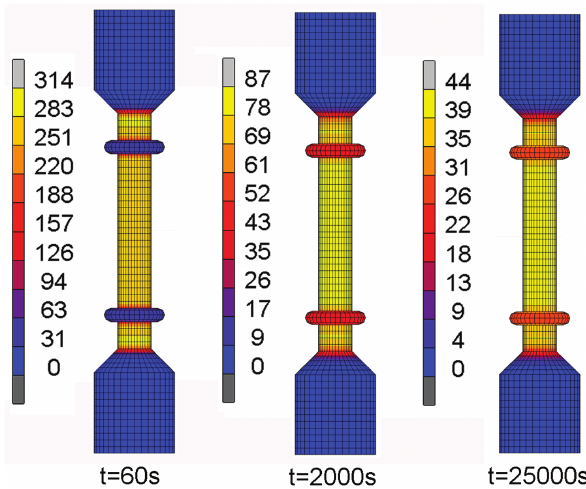
Figure 6: The distributions of effective stress at different time under 620°C.